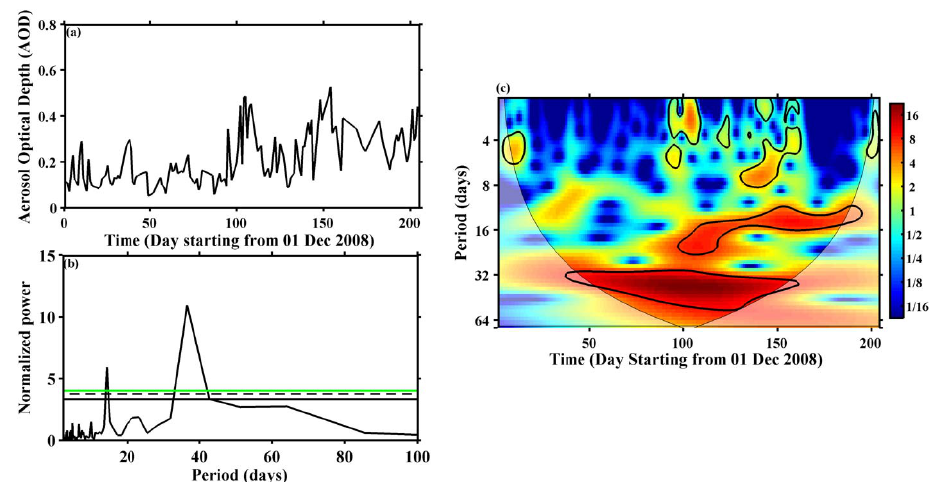
Fig. 1. (a) Time series of Microtops II Sun photometer AOD observed from December 2008 to June 2009 at 500nm. (b) Fourier spectrum showing dominant periodicity at 500nm for the data shown in (a) and (c) . Wavelet spectra plotted as a function of day number (starting from 1 December 2008) for 500nm. Contours in the wavelet spectra represent 90% confidence